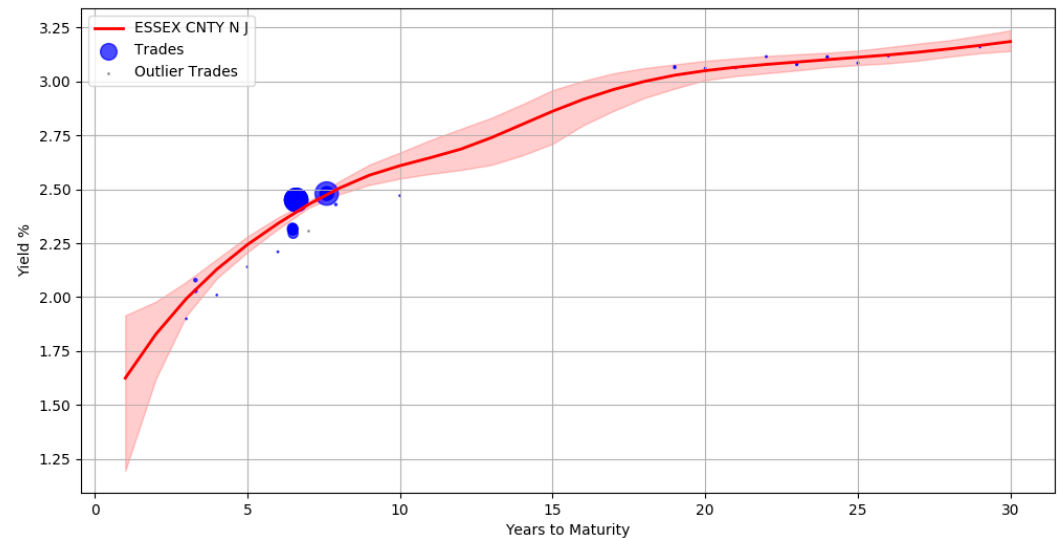
Figure 5. Capturing uncertainty in the estimates. The shaded region represents the uncertainty band around the mean.